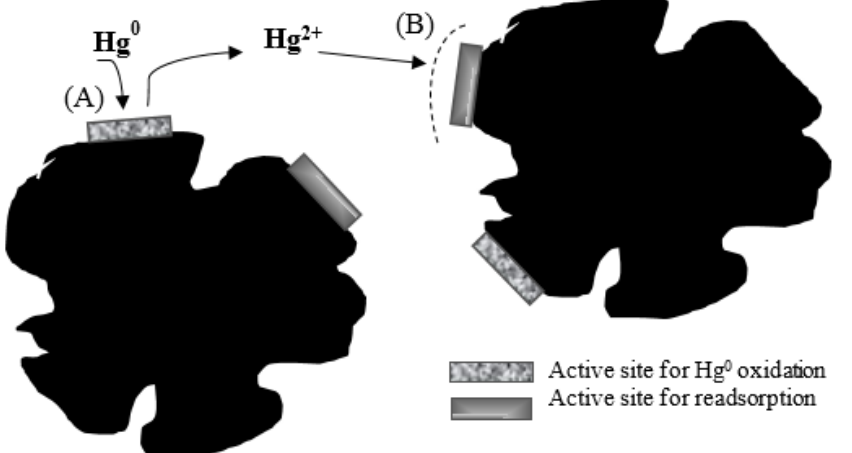
Figure 7. Effect of bromine content in the sorbent on Hg 0 oxidation.